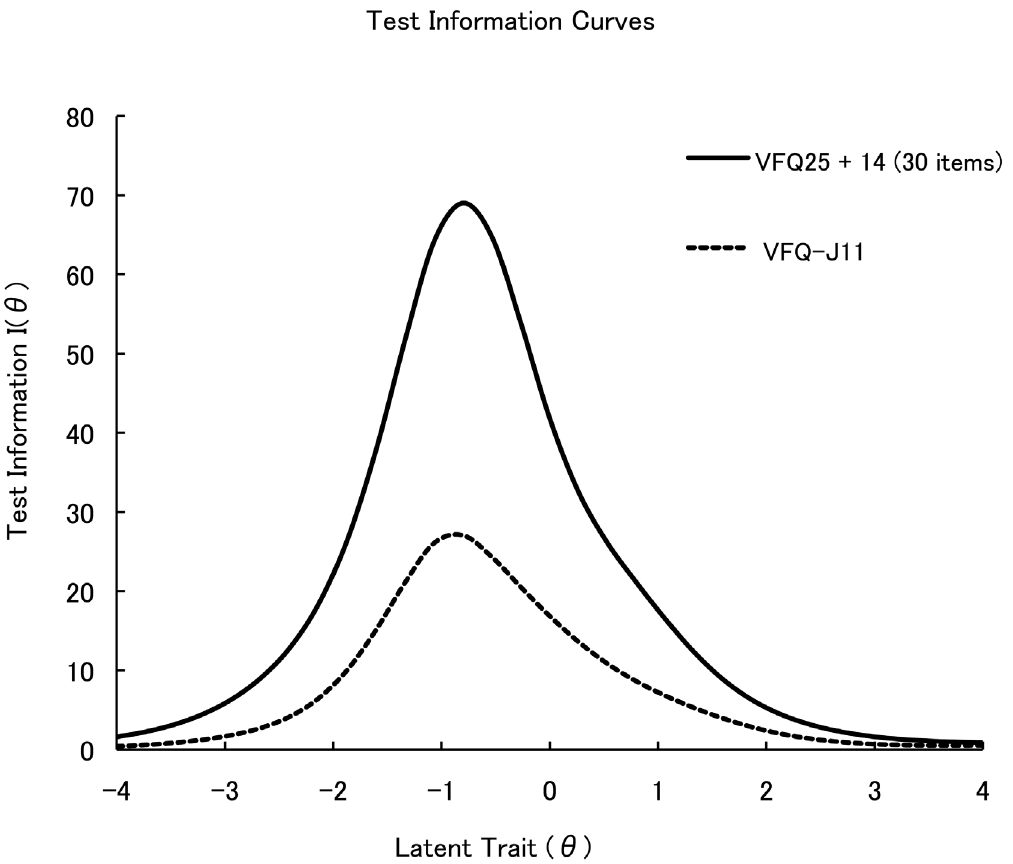
Figure 2. Test information functions for the VFQ25 and the VFQ-J11. Both functions reached their maxima at about the same value of the latent trait (a theta of approximately 2 0.8). For values of theta between approximately 2 2.0 and + 0.8, the test information for the VFQ-J11 was greater than 9, which indicates that in that range ( 2 2.0 to + 0.8) the test’s reliability is equivalent to or greater than a Cronbach’s alpha of 0.9.